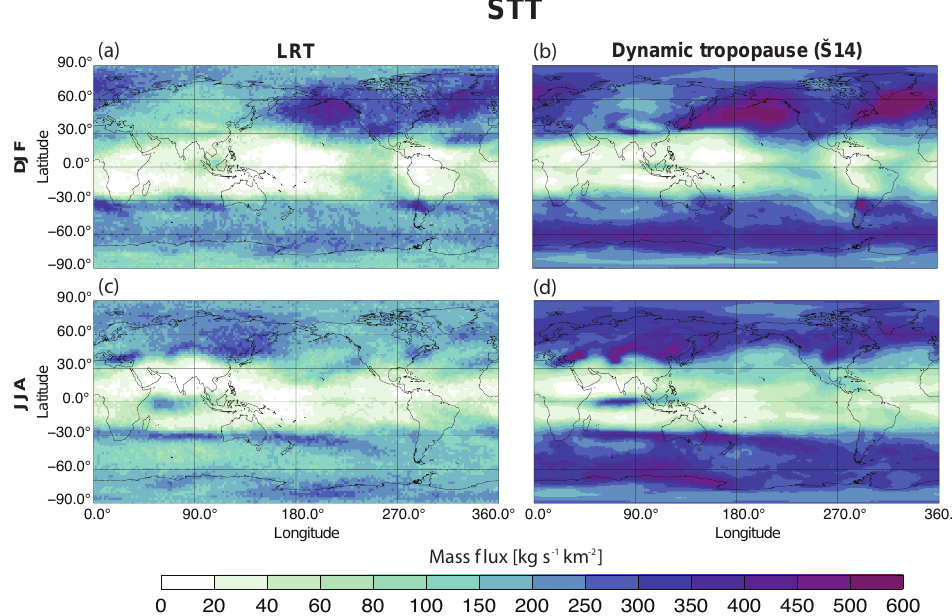
Figure 2. December, January, and February (DJF, top row) and June, July, and August (JJA, bottom row) mean STT mass fluxes for 1996– 2010 using the lapse-rate tropopause method (left) and for 1979–2011 using the dynamic tropopause method (right; from Škerlak et al., 2014).